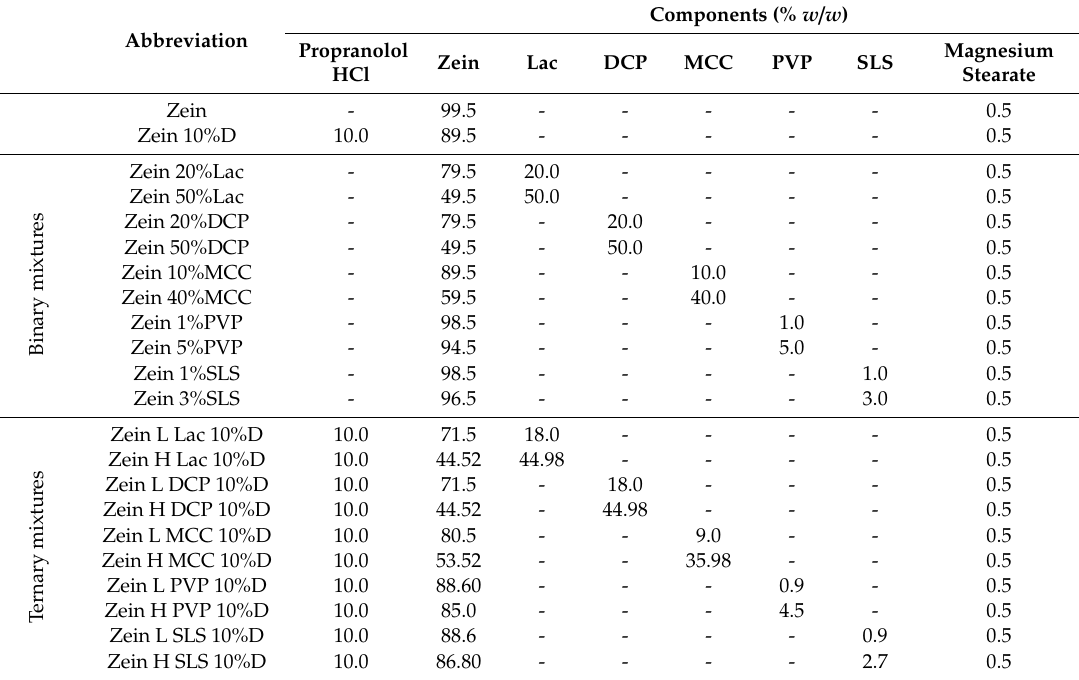
Table 1. Composition of zein-based matrix